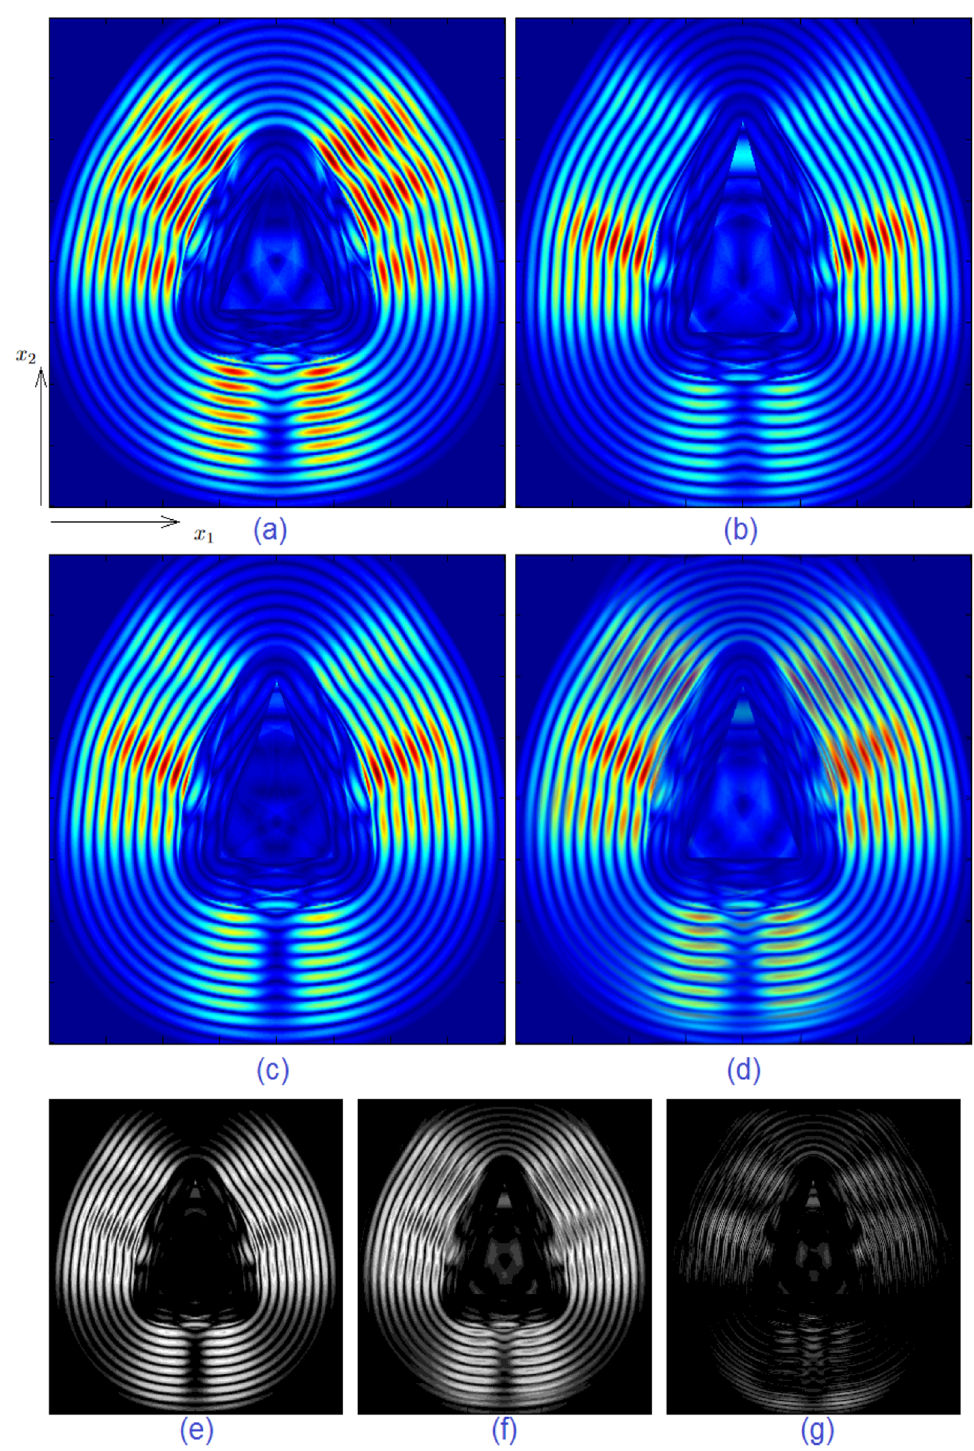
Fig. 3. Snapshot time t = 710 m s for the radiation pattern of a point force (directed along x 2 ) vibrating at frequency 10 kHz located at the gravity point of an isosceles triangle of height 4 20cm (b), isosceles triangle of height 5 similarities between (c) and (d). (e) is (c) transformed in a grayscale image, (f) is (d) transformed in a grayscale image, and (g) is the absolute value of the difference between (e) and (f). Note that the size of the fi eld is 80 cm by 80